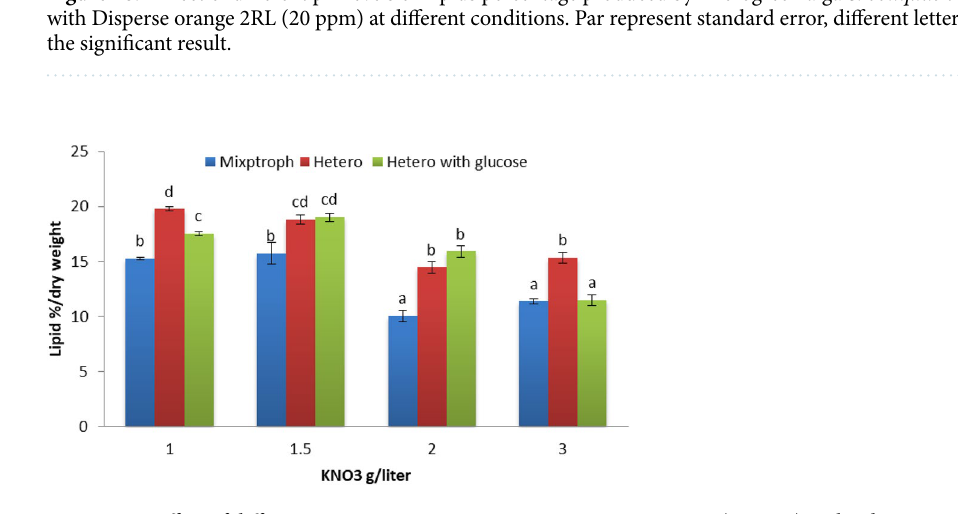
Figure 11. Effect of different nitrogen concentrations Disperse orange 2RL (20 ppm) on lipids percentage produced by microgreen alga S. obliquus that was grown at different conditions. Par represent standard error, different letters clear the significant